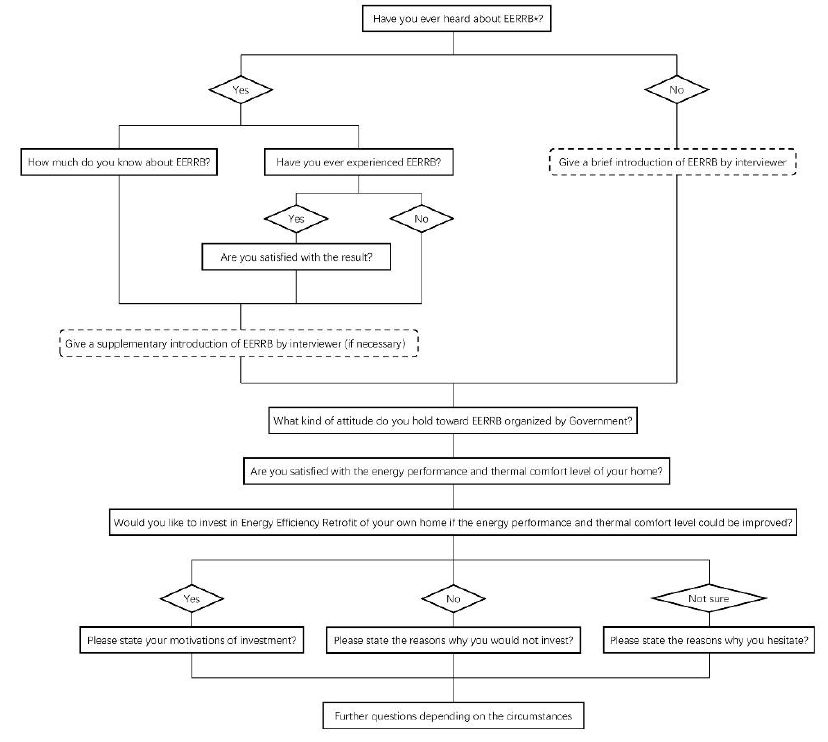
Figure 1. Structure of prepared questions at the beginning of interview. EERRB* stands for energy efficiency retrofit of residential